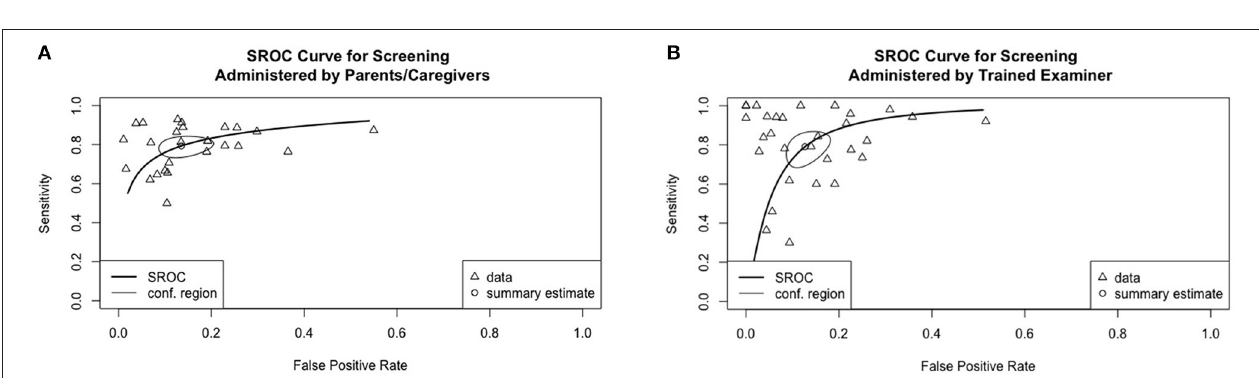
FIGURE 3 | Summary receiver operating characteristics curves for screening tools based on (A) , language ability, (B) clinical markers, and (C) language & clinical markers.